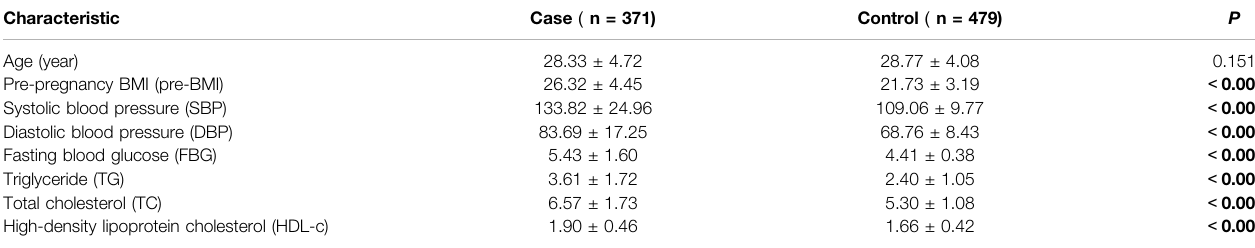
TABLE 1 | Characteristics of HDP cases and normotensive